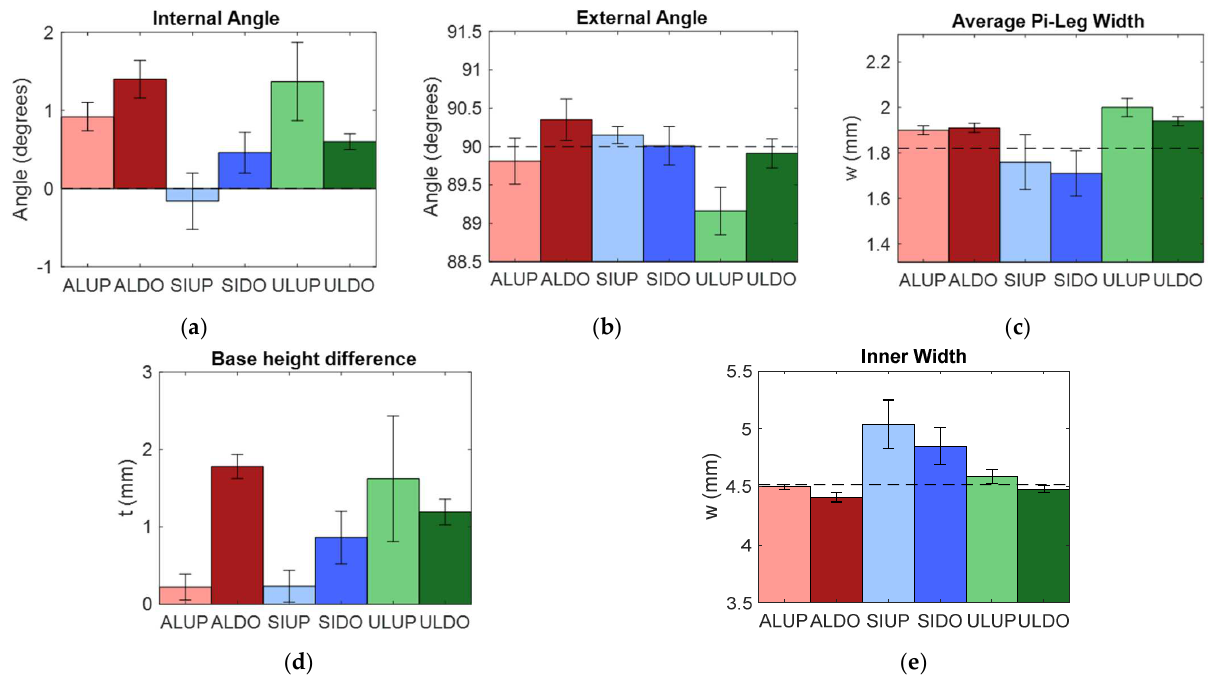
Figure 6. ( a–e ) Results of CT analysis on pi-NCF geometry. Left to right: internal angle, external angle, average pi-leg width, base height difference, inner width.